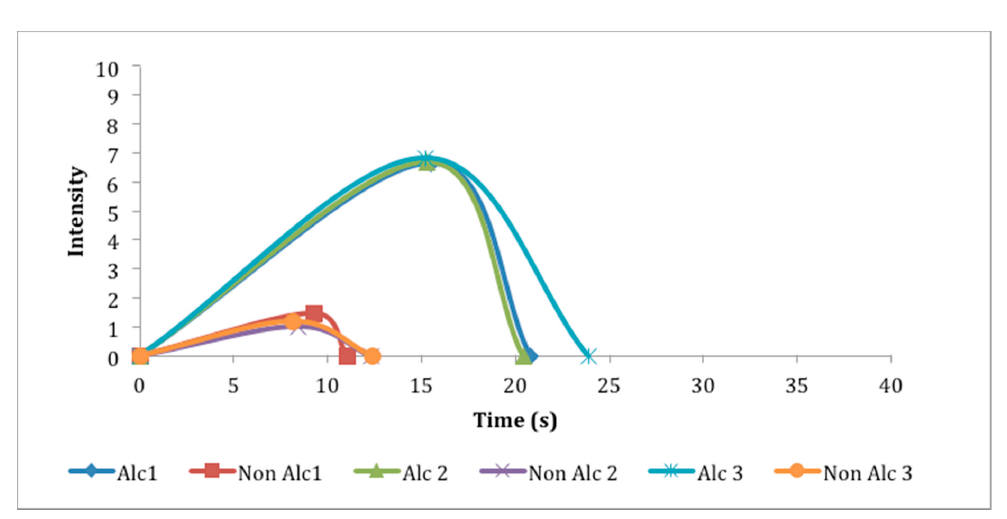
Table 4. Averages of the scores attributed by the time-intensity team to the alcoholic stimulus in alcoholic and non-alcoholic Pilsen beer samples for the evaluated attributes. A verages marked with equal letters on the same row do not differ statistically ( p ≤ 0.05) by Tukey’s